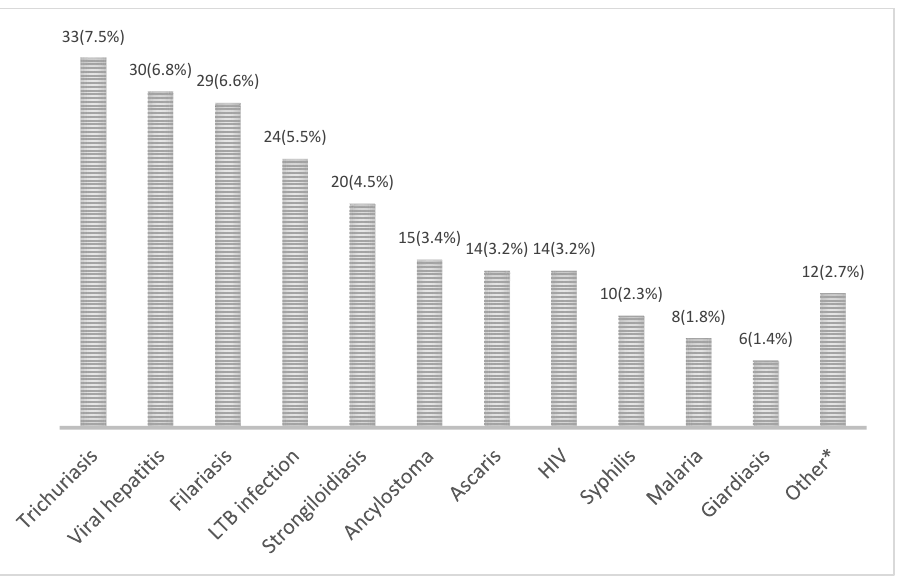
Figure 4. Absolute and relative frequency of newly diagnosed infections in the general cohort ( n = 440). HIV human immunodeficiency virus; LTB latent tuberculosis. * The category “other” included cases of amebiasis, gonorrhea and Mansonella , Toxocara canis , Taenia solium and Dicrocoelium dendriticum infections.